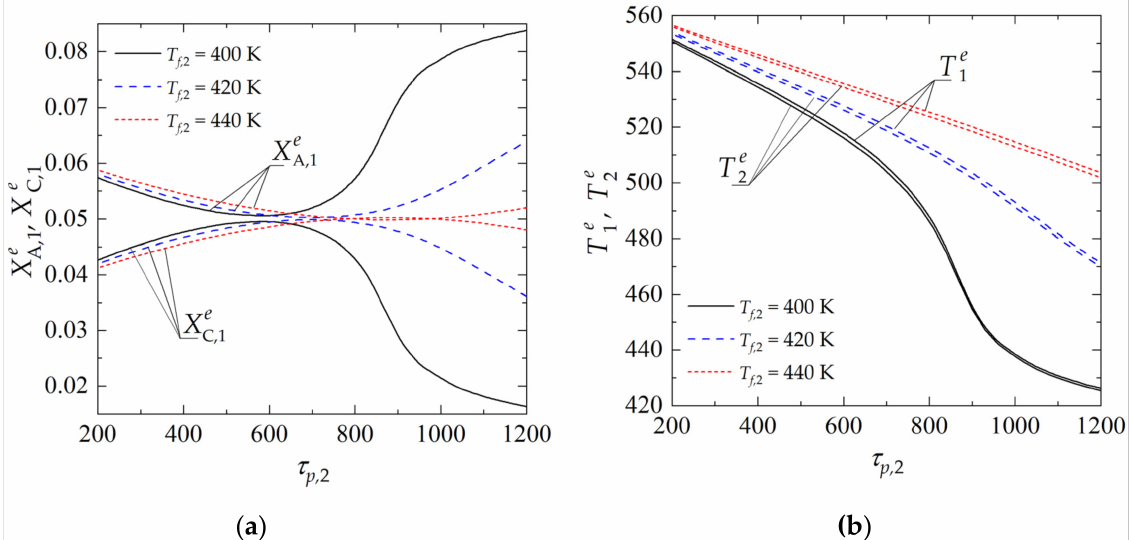
Figure 5. Dependence of state variables in the reactor ( j = 1) and regenerator ( j = 2) on the mean residence time of catalyst pellets in the regenerator τ p ,2 for different values of T f, 2 : ( a ) dimensionless concentration of component A and C in emulsion (dense) zone in the reactor; ( b ) temperature of the emulsion zone in the reactor and in the regenerator. (Calculations performed with E ads = 3 × 10 4 kJ · kmol − 1 , ∆ s = − 150 kJ · kmol − 1 · K − 1 , u 0,1 / u mf ,1 = u 0,2 / u mf ,2 = 2 and τ p ,1 = 600